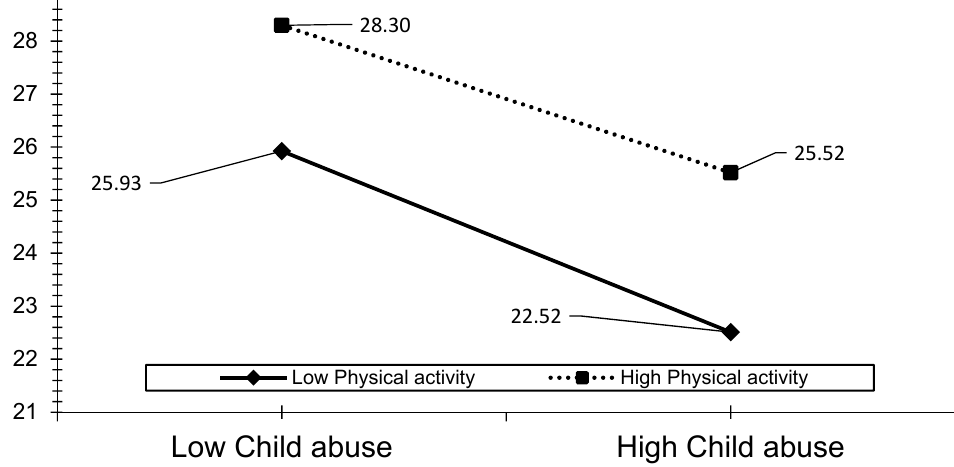
Figure 3. Model 2—Graph of interaction effect between PA and child abuse on HRQOL.